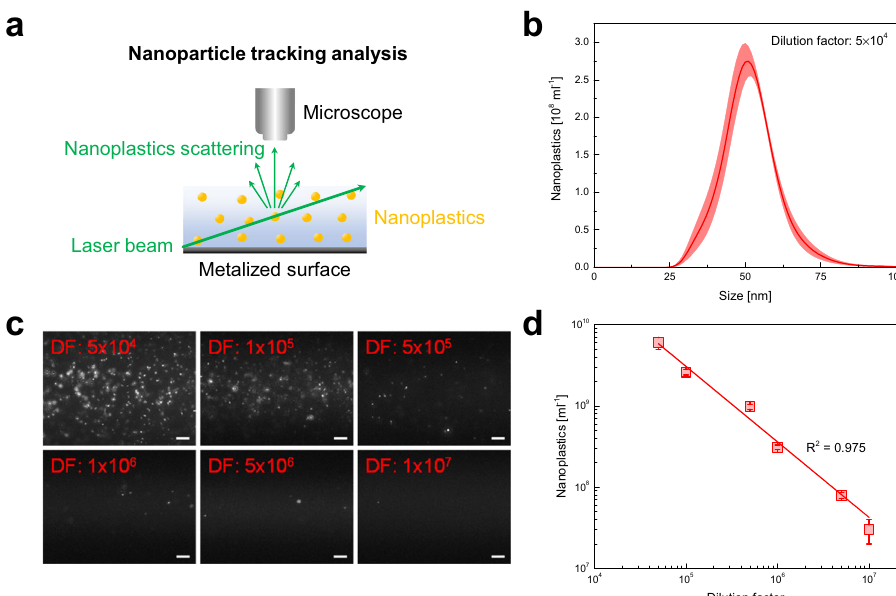
Fig. 5 Nanoparticle tracking analysis (NTA). a Scheme of the NTA working principle. b Size distribution of the nanoplastics ’ suspension (carboxylated polystyrene nanoparticles in water) after the dilution by a factor 5 × 10 4 measured by NTA. The shaded region replaces the discrete error bars calculated as the standard error for n = 3 independent replicates. c Frames of the videos of nanoplastics ’ suspensions after serial dilution and d the corresponding calibration curve showing the linear range for NTA. Scale bars are 10 μ m. Error bars represent the standard deviation, n = 3 independent